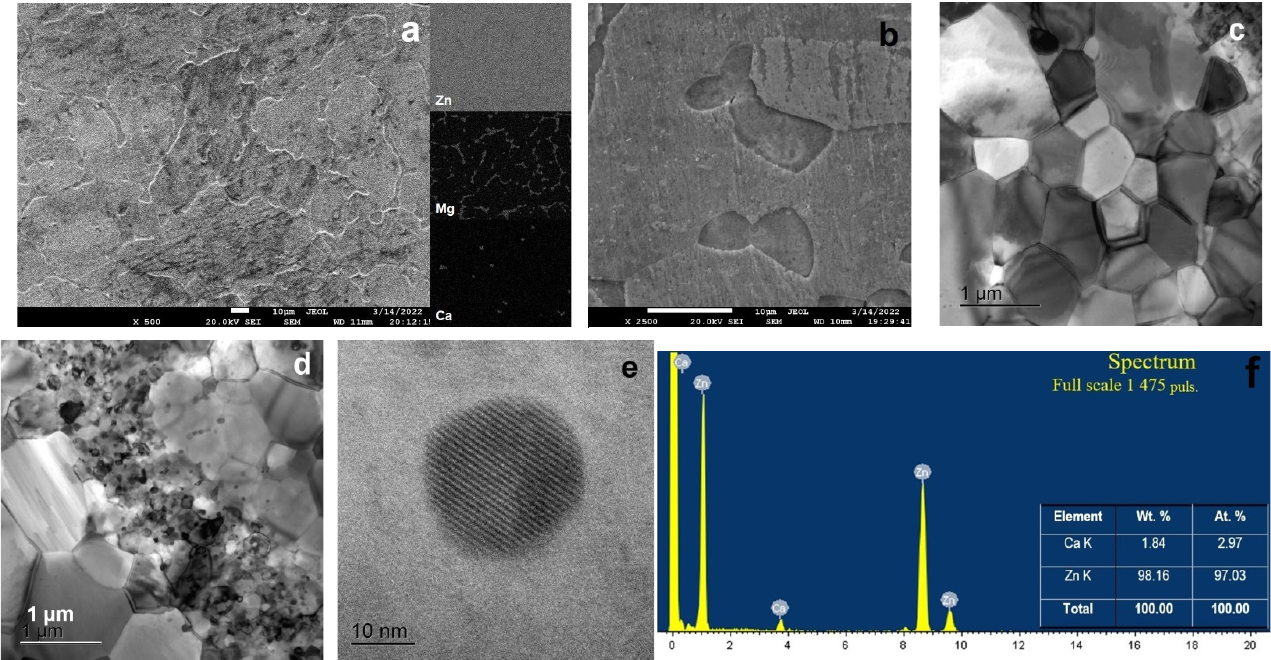
Figure 1. SEM-image (SE-contrast) structure and elemental SEM-EDS-mapping of the Zn-1%Mg-0.1%Ca alloy in the initial state ( a , b ) and the TEM images (bright field) of structure of the Zn-1%Mg-0.1%Ca alloy after HPT ( c , d ). HRTEM-image of intermetallic particle based on Zn-Ca ( e )